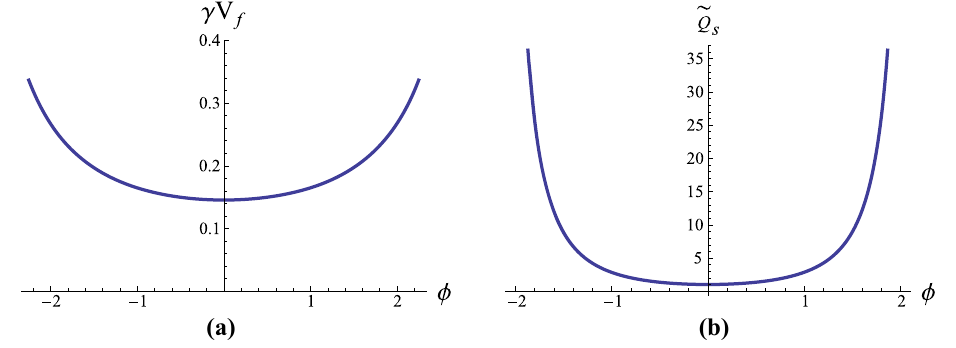
Fig. 1 The perturbation potential V f and the even zero mode solution ˜ Q s for f ( R ) = R + γ R 2 . a The perturbation potential. b The even zero